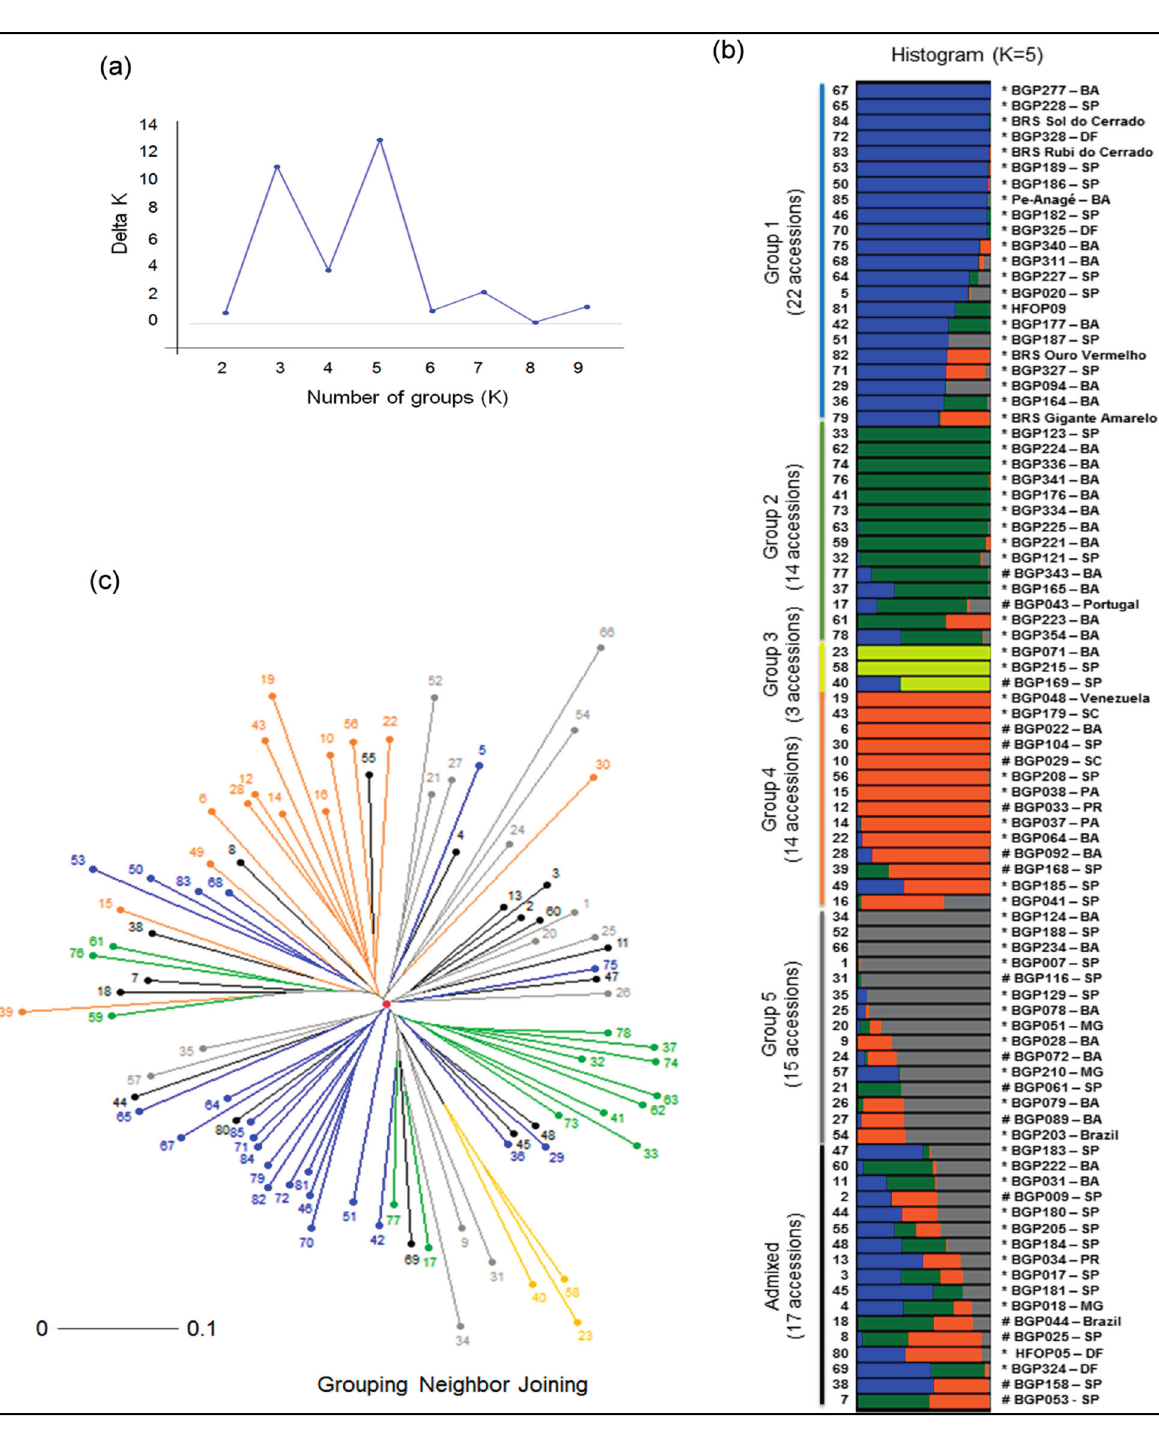
Figure 3. Intraspecific genetic structure of P. edulis . Clusters were inferred based on Bayesian analyses considering the most probable number of groups (K) estimated with the method described by Evanno et al. [43] ( a ); Each column (histogram) ( b ) and line (unrooted neighbor-joining tree) ( c ) represents the genotyping data from three plants. The tree was constructed using Rogers’ genetic distance, as modified by Wright [42], among 85 passion fruit accessions. The colors used in the histogram and tree represent the most likely ancestry of the cluster from which the accessions were derived. Accessions that produce fruits with yellow and purple peels are indicated with * and #,